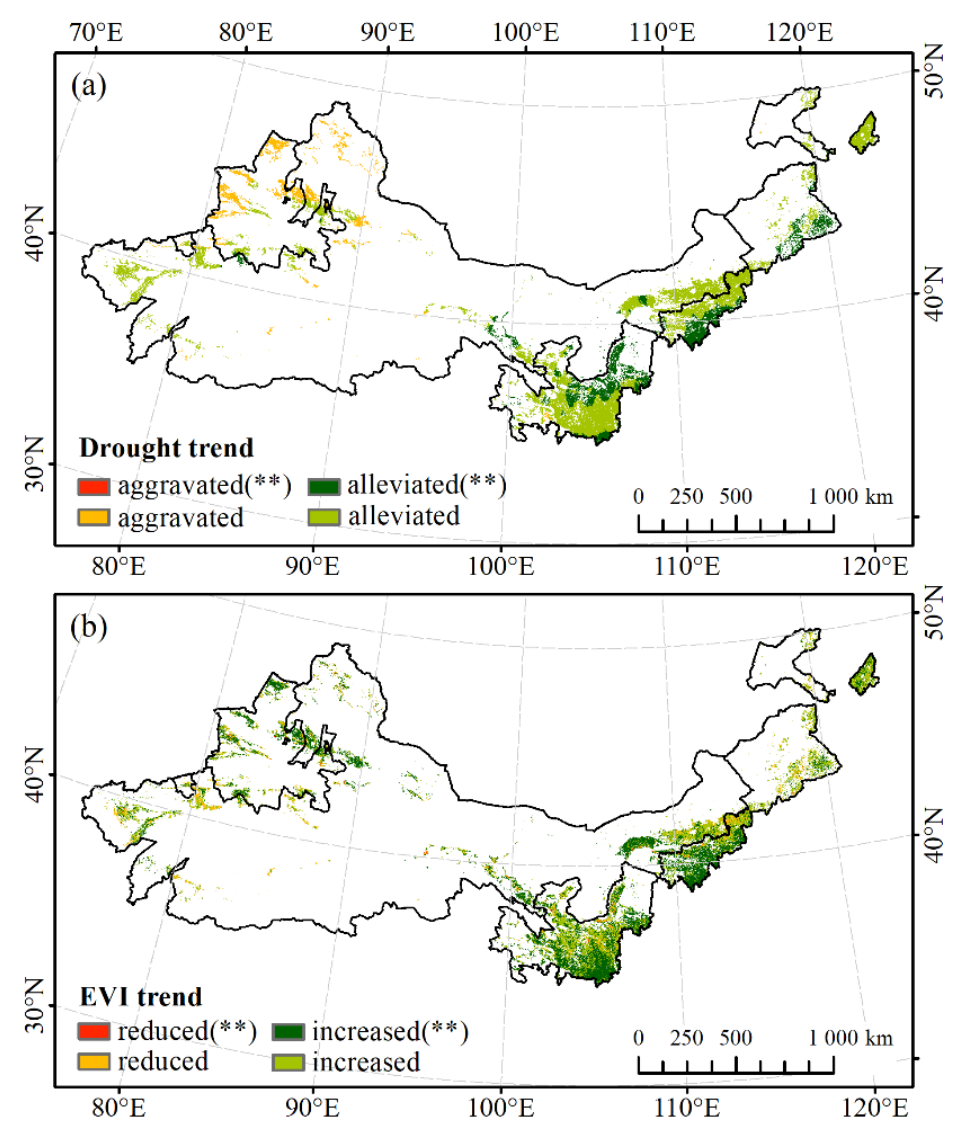
Figure 3. The spatial distribution of trends in drought ( a ) and enhanced vegetation index (EVI) ( b ) during growing season in farmland ecosystems in the drylands of northern China (DNC) from 2000 to 2018. ** means significance of trends were assessed at p < 0.05. The trends in drought and EVI during the growing season in farmland ecosystems in the DNC from 2000 to 2018 is shown in Figure 4. During this period, the growing season trends in the drought index and EVI of farmland were consistent in both drylands and semi-arid drylands. The drought index and EVI during the growing season all showed an upward trend, that is, the drought was alleviated and the EVI increased. Furthermore, there was a regional difference in the degree of drought reduction and EVI increase. The change trends of drought index were more obvious in semi-arid drylands than in arid drylands. The increasing rates of EVI in arid and semi-arid drylands were approximately the